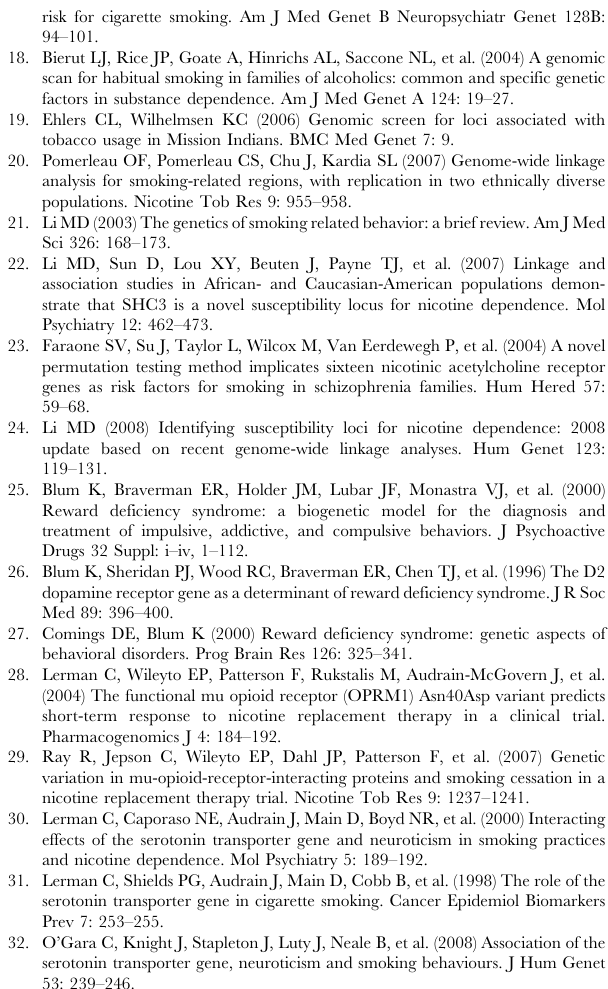
Found at: doi:10.1371/journal.pone.0004653.s001 (0.04 MB XLS)